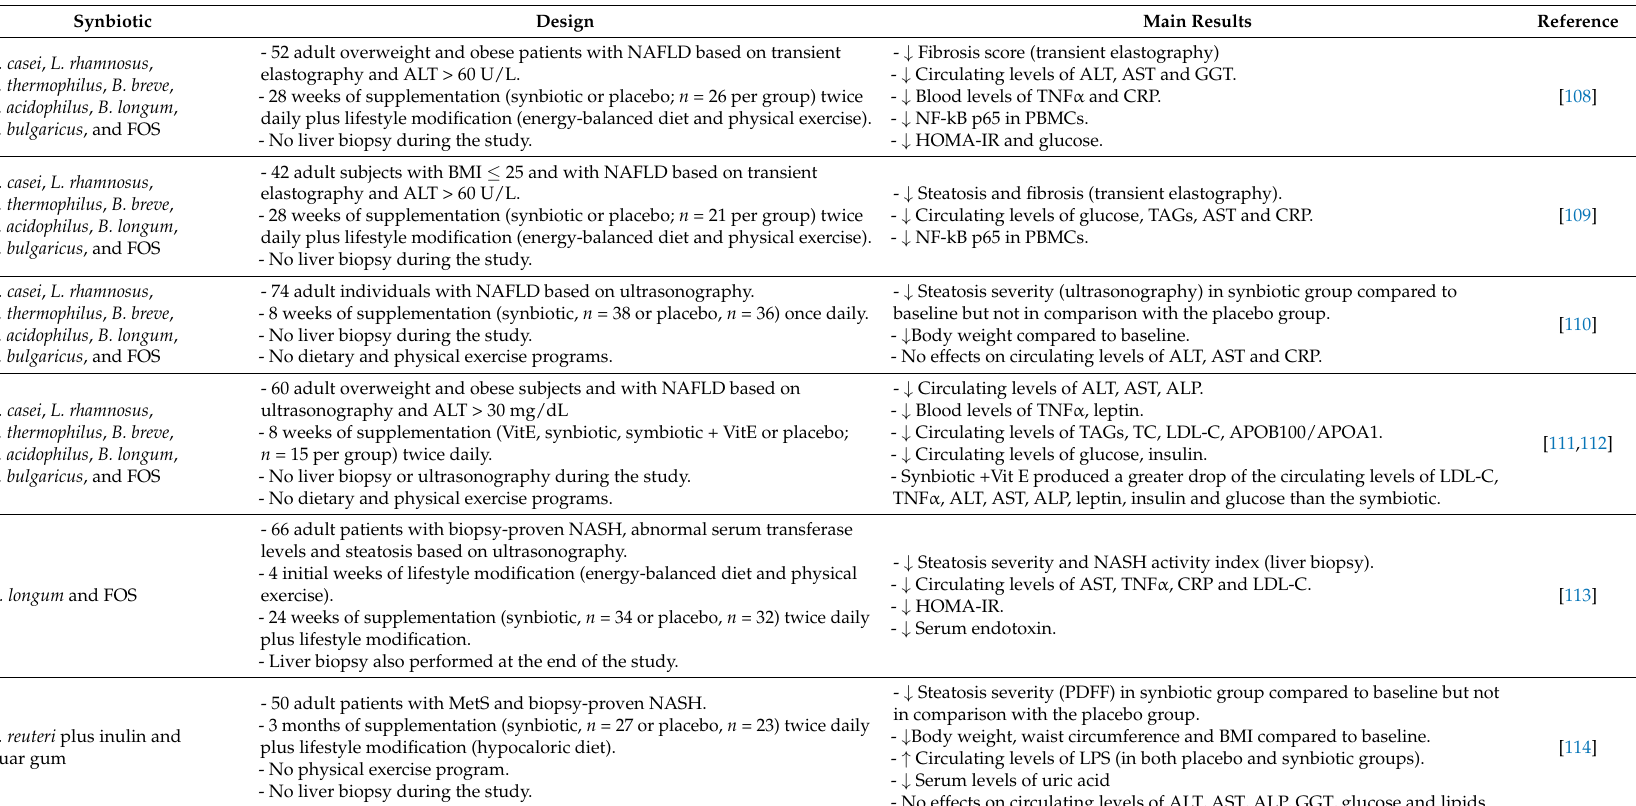
Table 3. RCT aimed to evaluate the effects of synbiotics against NAFLD and